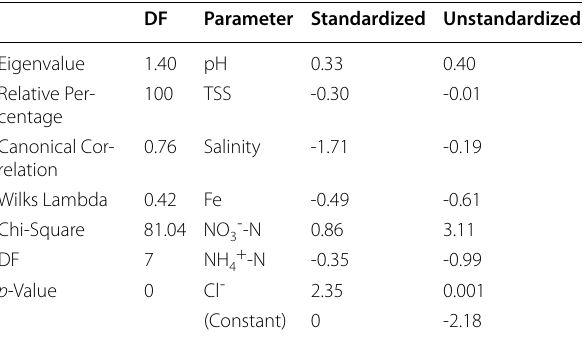
Table 4 Description of the significance level and